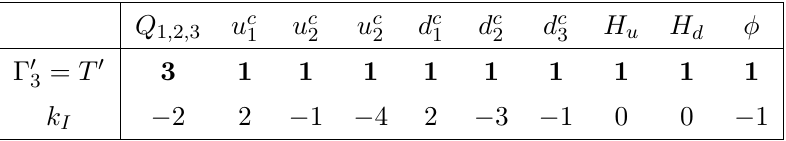
Table 2. The representations and the modular weights of the chiral